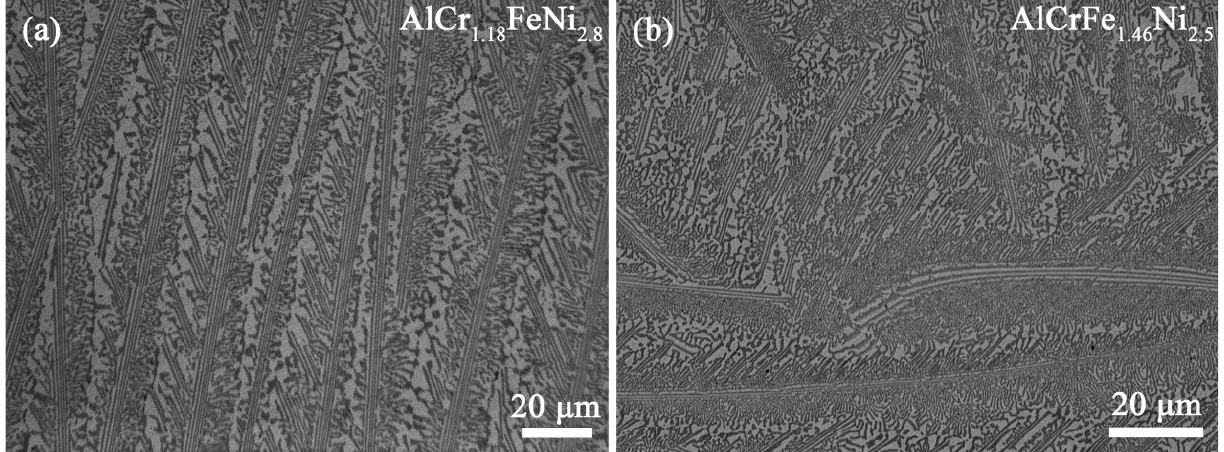
Figure 2. XRD patterns of the AlCr 1.18 FeNi 2.8 and AlCrFe 1.46 Ni 2.5 alloys.